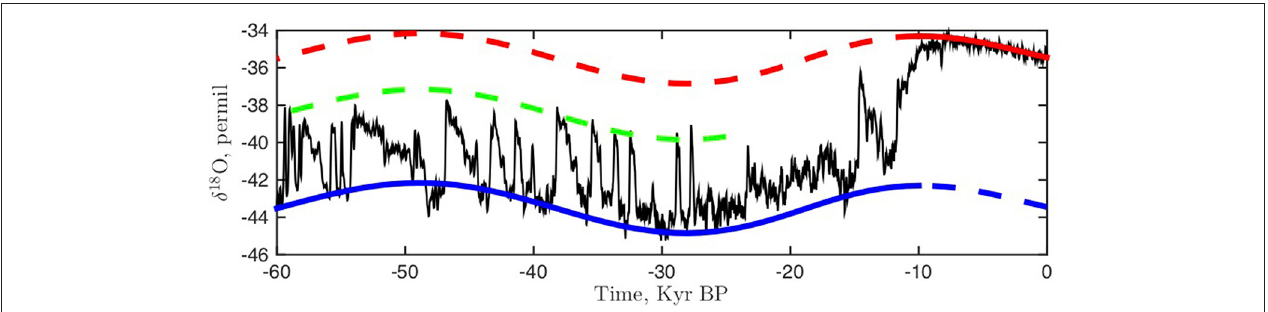
FIGURE 1 | The NGRIP isotope record [18] for the past 60 kyr is a proxy for temperature. The red, green and blue curves are the summer insolation at 65N fitted to the climate record. The red curve is fitted to the present Holocene climate, the blue curve is shifted to fit the cold stadial state, while the green curve is shifted to fit the interstadial states.